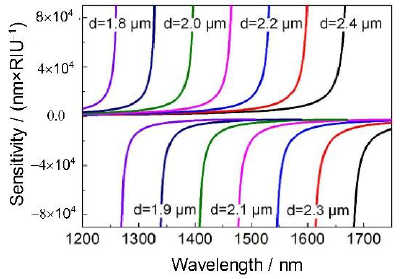
Figure 7. The surrounding refractive index sensitivities of interference fringes around CWLs at dif- ferent waist diameters of microfibers. Adapted with permission from Ref. [28].